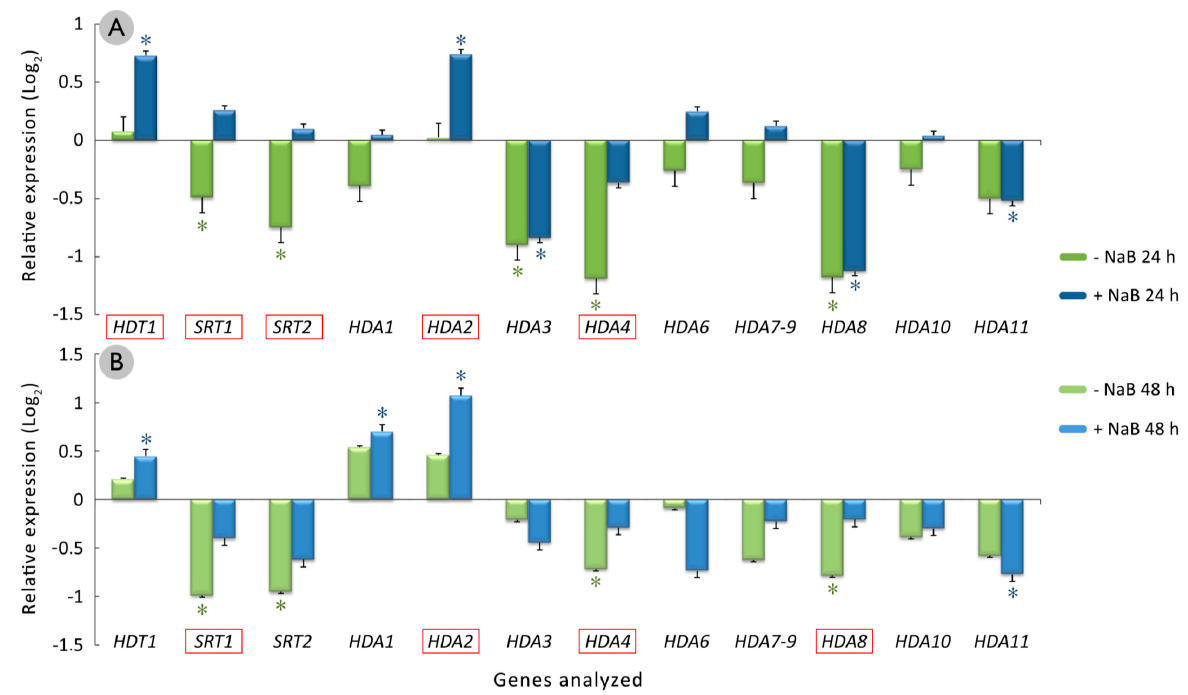
Figure 6. Relative expression of HDAC-encoding genes in grapevine cv. Mencía cotyledonary somatic embryos that were cultured in the induction medium supplemented with 0.5 mM NaB (blue) or without NaB (green) for ( A ) 24 and ( B ) 48 h. The mean values of the two independent experiments ± standard errors are shown. Asterisks indicate statistically significant differences ( p < 0.05) between the calibrator group (cotyledonary somatic embryos used as starting material) and the analyzed group, while the red squares framing genes indicate statistically significant differences ( p < 0.05) between the NaB and no NaB treatments.